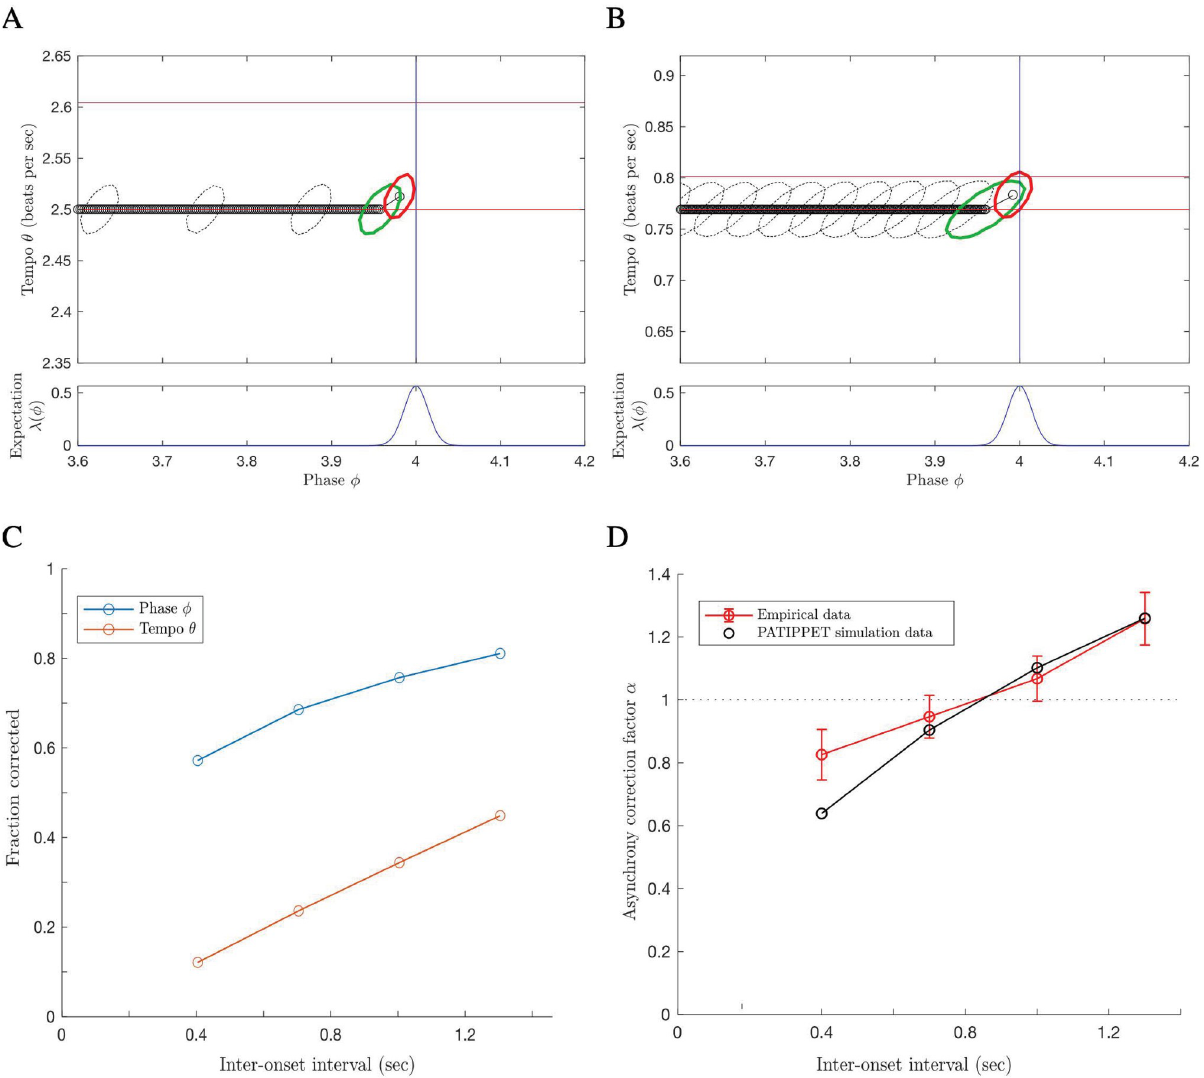
Fig 6. PATIPPET reproduces human tapping data showing stronger error correction for longer inter-onset intervals. A and B) The distribution on phase and tempo leading up to and following a phase shift at the fourth event in an isochronous sequence for two different metronome tempi, i.e., two different inter-onset intervals. (Same color key as Fig 5, but with phase/tempo distribution contours strobed every.05 sec). Note that when the IOI is short, PATIPPET arrives at the phase-shifted event with a high degree of phase and tempo certainty. C) PATIPPET makes a proportionally larger correction to phase and tempo for long IOIs than for short IOIs due to the greater degree of uncertainty preceding each event. D) Alpha ( α ) is the proportion of a phase shift that is corrected at the next tap time. With this set of parameters, PATIPPET reproduces the empirical observation from [35] that the phase shift is undercorrected when IOIs are short and overcorrected α > 1 when IOIs are